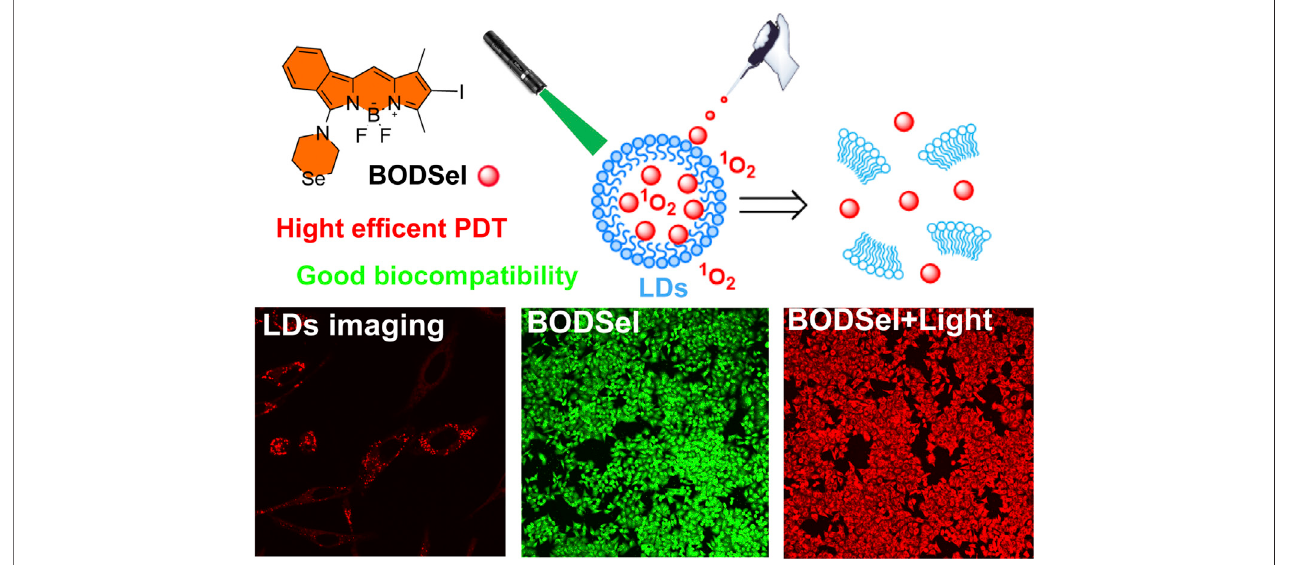
FIGURE 1 | Schematic illustration of the LD-targeted strategy for photodynamic